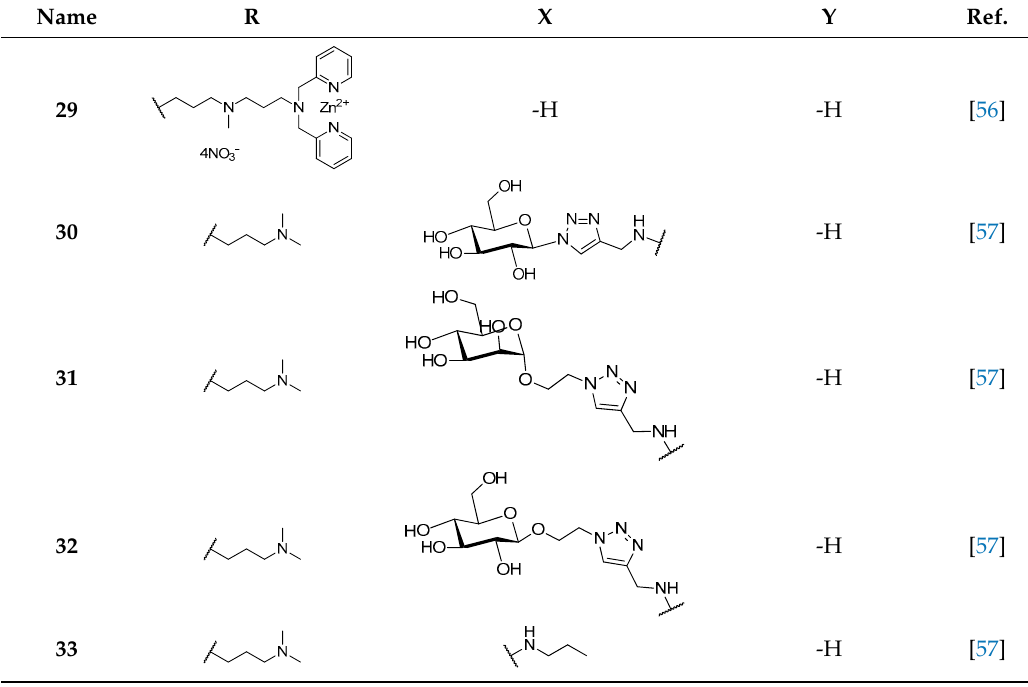
Table 1. Structures of NDIs used as reversible ligands to stabilize telomeric G4s.